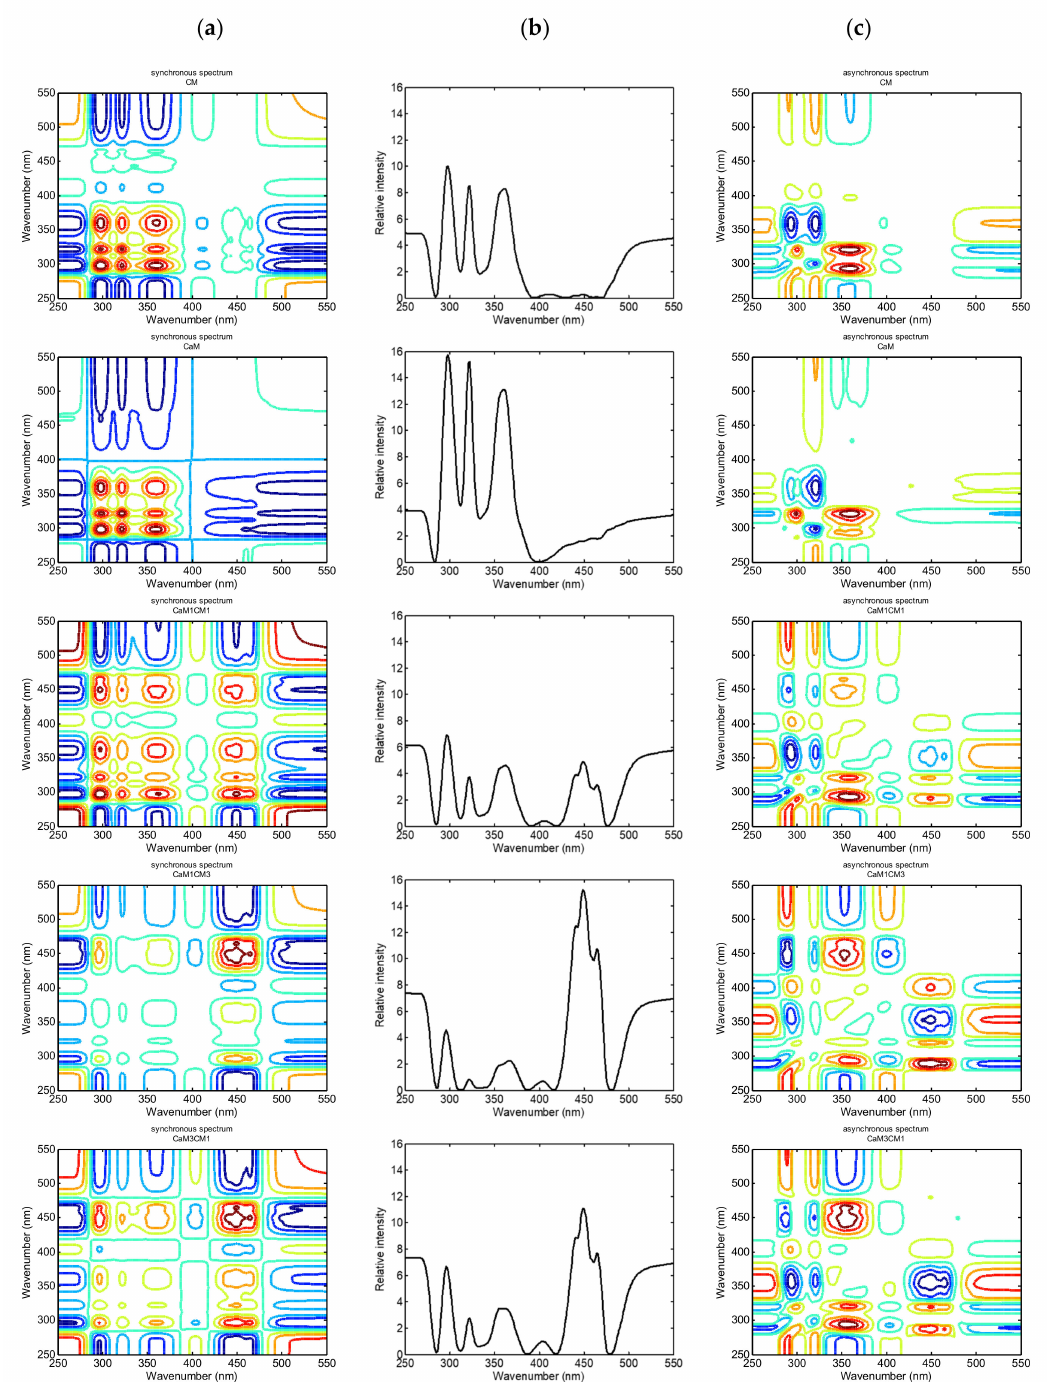
Figure 2. Synchronous spectra ( a ), auto-peak spectra ( b ) and asynchronous spectra ( c